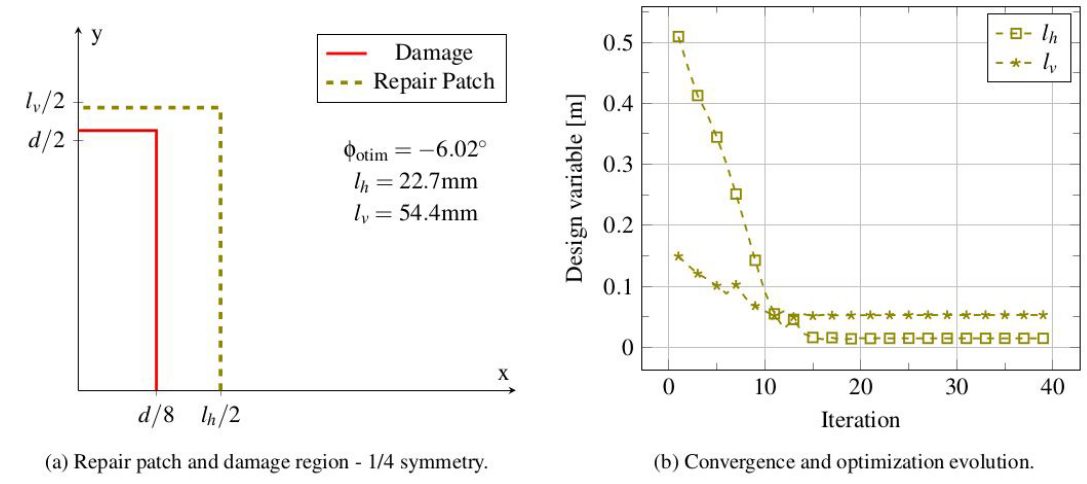
Figure 4. Rectangular repair patch - SS with symmetric stacking sequence.